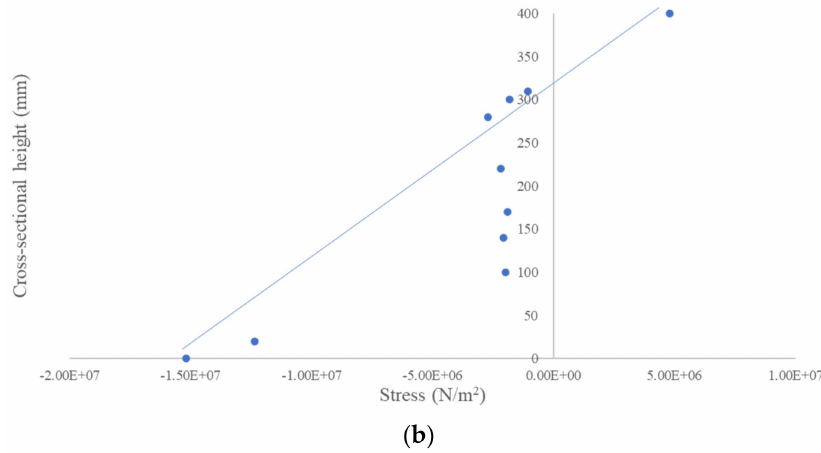
Figure 12. ( a ) The stress distribution in the longitudinal direction of the cross-section of strain gauge locations in S3. ( b ) Stress distribution over the cross-section with strain gauges in S3.